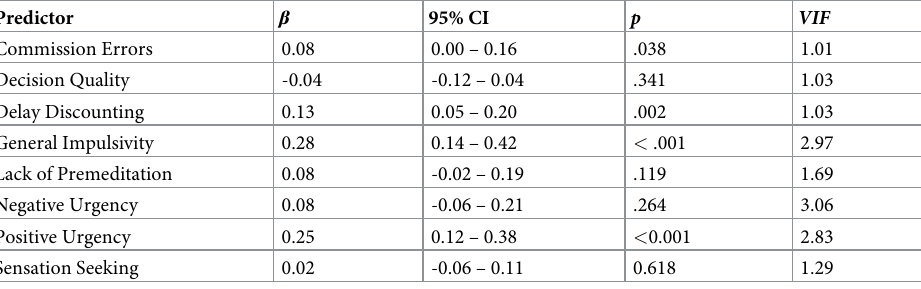
Table 4. Regression Model 3 results predicting the lifestyle facet. Predictor β Commission Errors